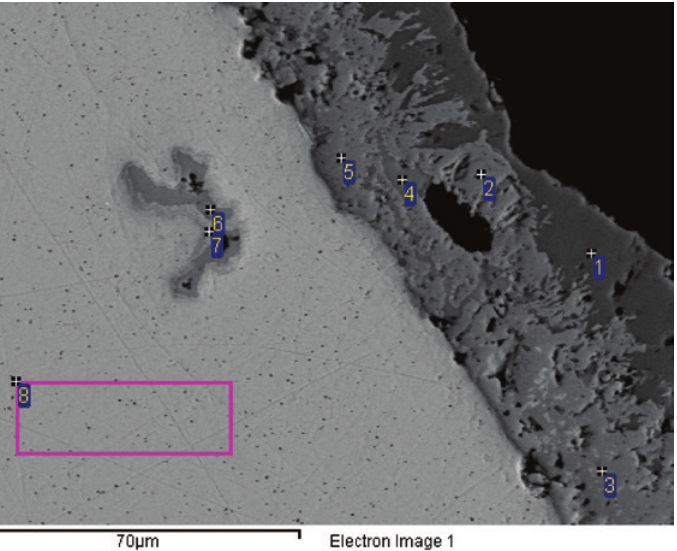
Fig. 3: Copper oxide scales on Cu 2 Se generated by a flowing dry O 2 roasting atmosphere at 550 °C within 4 h reaction time; the outer layer against the atmosphere is CuO (points 1, 4) and the inner predominantly of Cu 2 O (points 2–3, 5) with scales of selenium-copper-oxides (points 6–7), the non-reacted base material (area 8) is of Cu 2 Se.